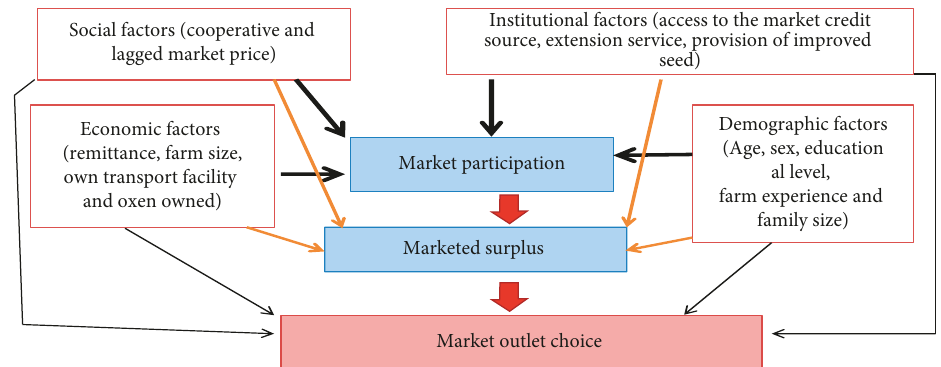
Figure 1: Conceptual framework of the study. Source: Adopted from review of different literatures